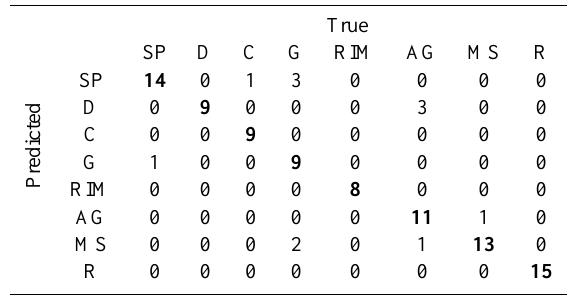
Table 2. Example of a confusion matrix obtained during validation of the SVM classification for a validation set N ∗ tions. Correct classifications are situated on the diagonal, and mis- classifications are in the off-diagonal